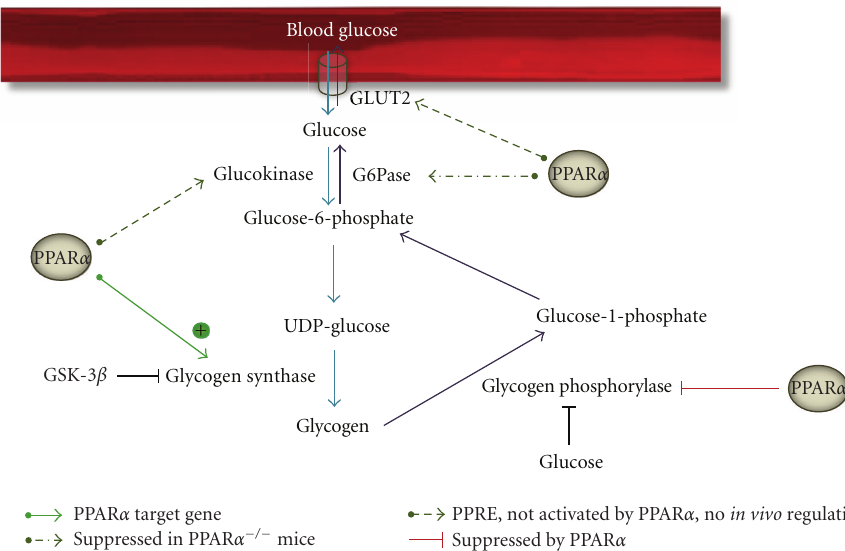
Figure 3: Influence of PPAR α on hepatic glycogen metabolism. Synthesis (blue arrows) and breakdown of glycogen (purple arrows) are depicted, together with the regulatory e ff ects of PPAR α . Direct transcriptional influence is presented as a full green arrow. An e ff ect that was only observed in PPAR α − / − mice is depicted as a dark green dashed arrow. Genes in which a PPRE was identified, but no in vivo activation by PPAR α was observed are presented with a dark green dotted arrow. A suppressive e ff ect of PPAR α is shown with a red mark. G6Pase: glucose-6-phosphatase; GLUT2: glucose transporter 2; GSK-3 β : glycogen synthase kinase 3 β ; UDP-glucose: uridine diphosphate